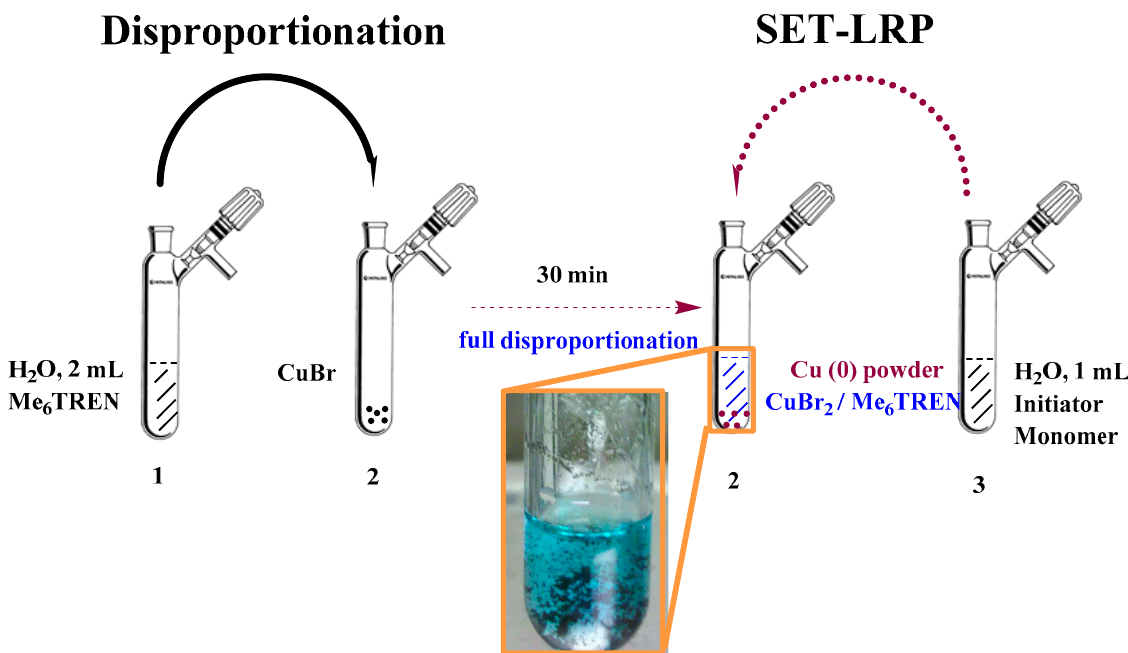
O Scheme 2. Synthesis of polydimethylacrylamide (PDMA) (degree of polymerization (DP) = 10, 20, 40, and 80) by Cu(0)- mediated polymerization in water at 0.0 °C via prior disproportionation of copper bromide. Conditions: [WSI]:[CuBr]:[Me 6 TREN] = 1:0.4:0.4. Homopolymerization of DMA in aqueous solutions was exploited employing the Cu(0)-mediated polymerization approach. Initially, the polymerization of DMA was in- vestigated using the aforementioned conditions: [DMA]:[WSI]:[CuBr]:[Me 6 TREN] = [10 or 20]:[1]:[0.4]:[0.4]. 1 H NMR analysis confirmed that 100% monomer conversion was achieved in 8 min for each DP = 10 and 20. SEC traces revealed one symmetrical peak distribution with narrow MWDs (DP = 10, Đ ~1.09 and DP = 20, 1.28), demonstrating the controlled nature of the system (Table 1 and Figure 1). Nonetheless, the appearance of a small low molecular weight shoulder was detected in the case of DP = 20, indicating the lack of a catalyst. When the target was DP = 40, the synthesis was primarily conducted utilizing previous conditions; however, a broad